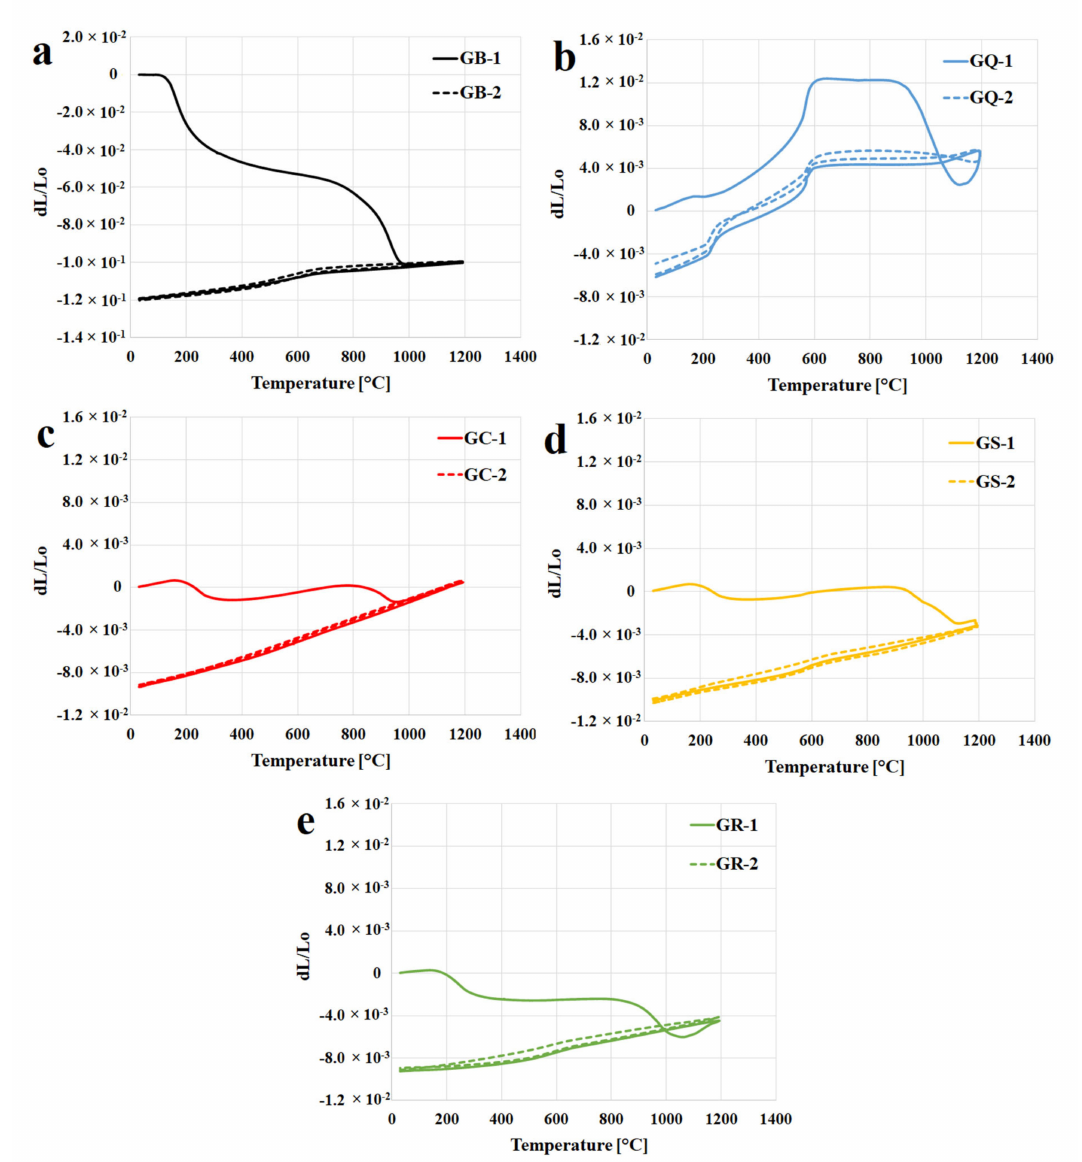
Figure 3. The dilatometric curves of first and second runs of geopolymer binder ( a ) and composites ( b —quartz, c —corundum, d —chamotte, e —cordierite) up to 1200 ◦ C (5 ◦ C /